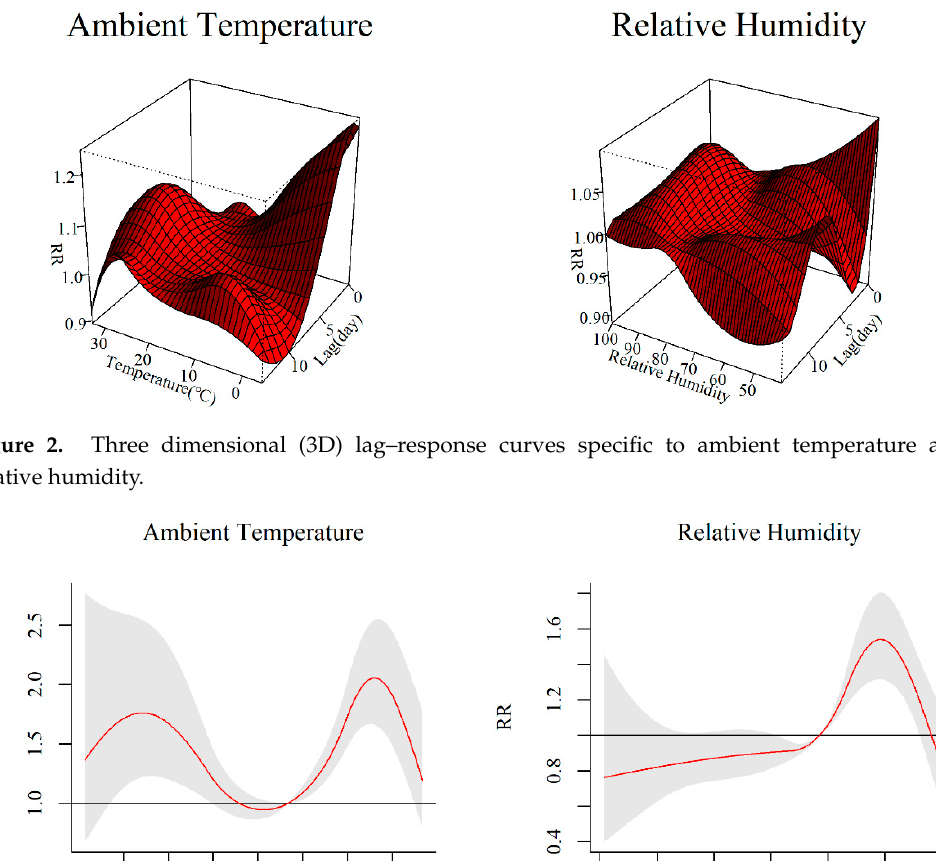
Figure 3. Cumulative effects of ambient temperature and relative humidity on HFMD incidence within 14 days.